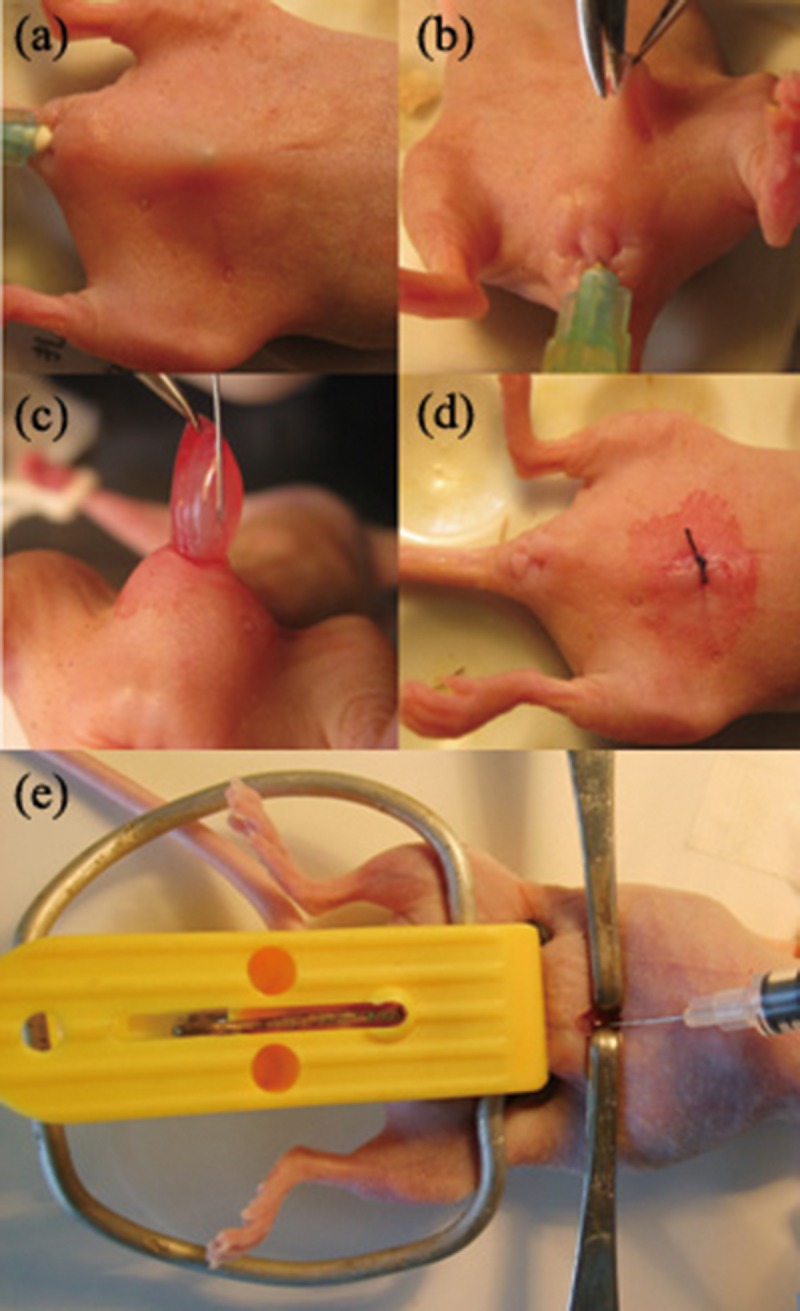
Establishment and treatment methods of BALB/c-nu mouse model of invasive bladder carcinoma.(a) Insert the hard elbow urinary catheter into the bladder to determine the surgical incision. (b) Cut the abdominal wall layer by layer. (c) Inject tumor cells into the bladder wall. (d) Suture the incision with 4–0 nylon. (e) Inject the drugs into the abdominal aorta of the BALB/c-nu mouse by using a 1 mL insulin syringe.